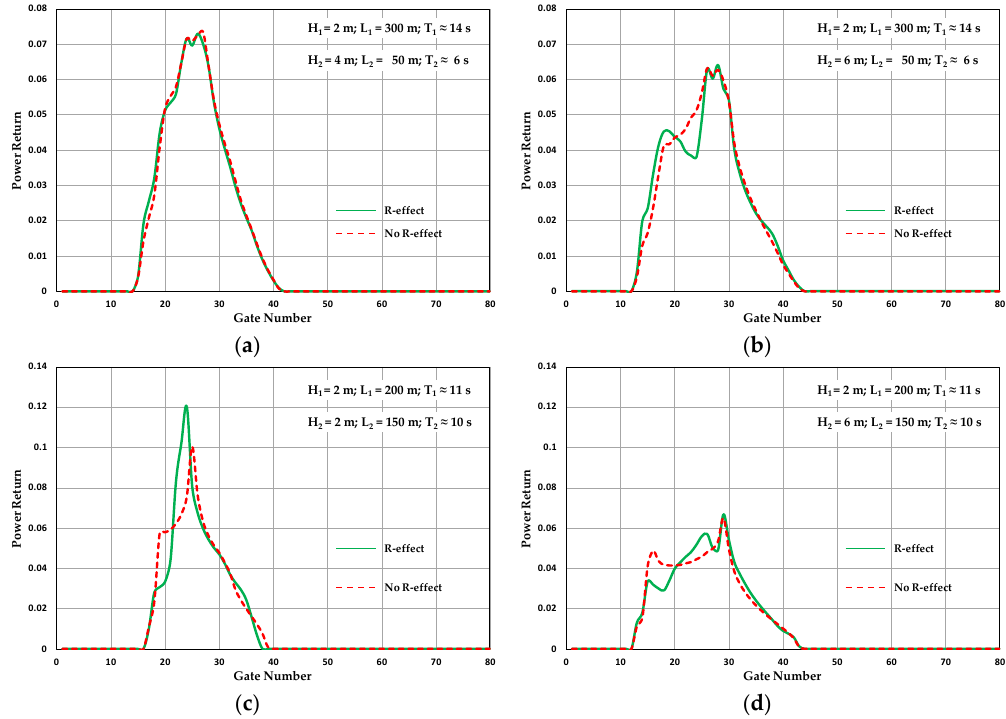
Figure 7. Simulated waveform with (solid green line), and without (dashed red line), R-effect when a longer sinusoidal wave train (wave height H , wavelength L 1 ) is superimposed to a shorter one (wave height H 2 and wavelength L 2 ): ( a ) H 2 = 4 m, L 2 = 50 m; ( b ) H 2 = 6 m, L 2 = 50 m. ( c ) H 2 = 2 m, L 2 = 150 m; (d) H2 = 6 m, L2 = 150 m.